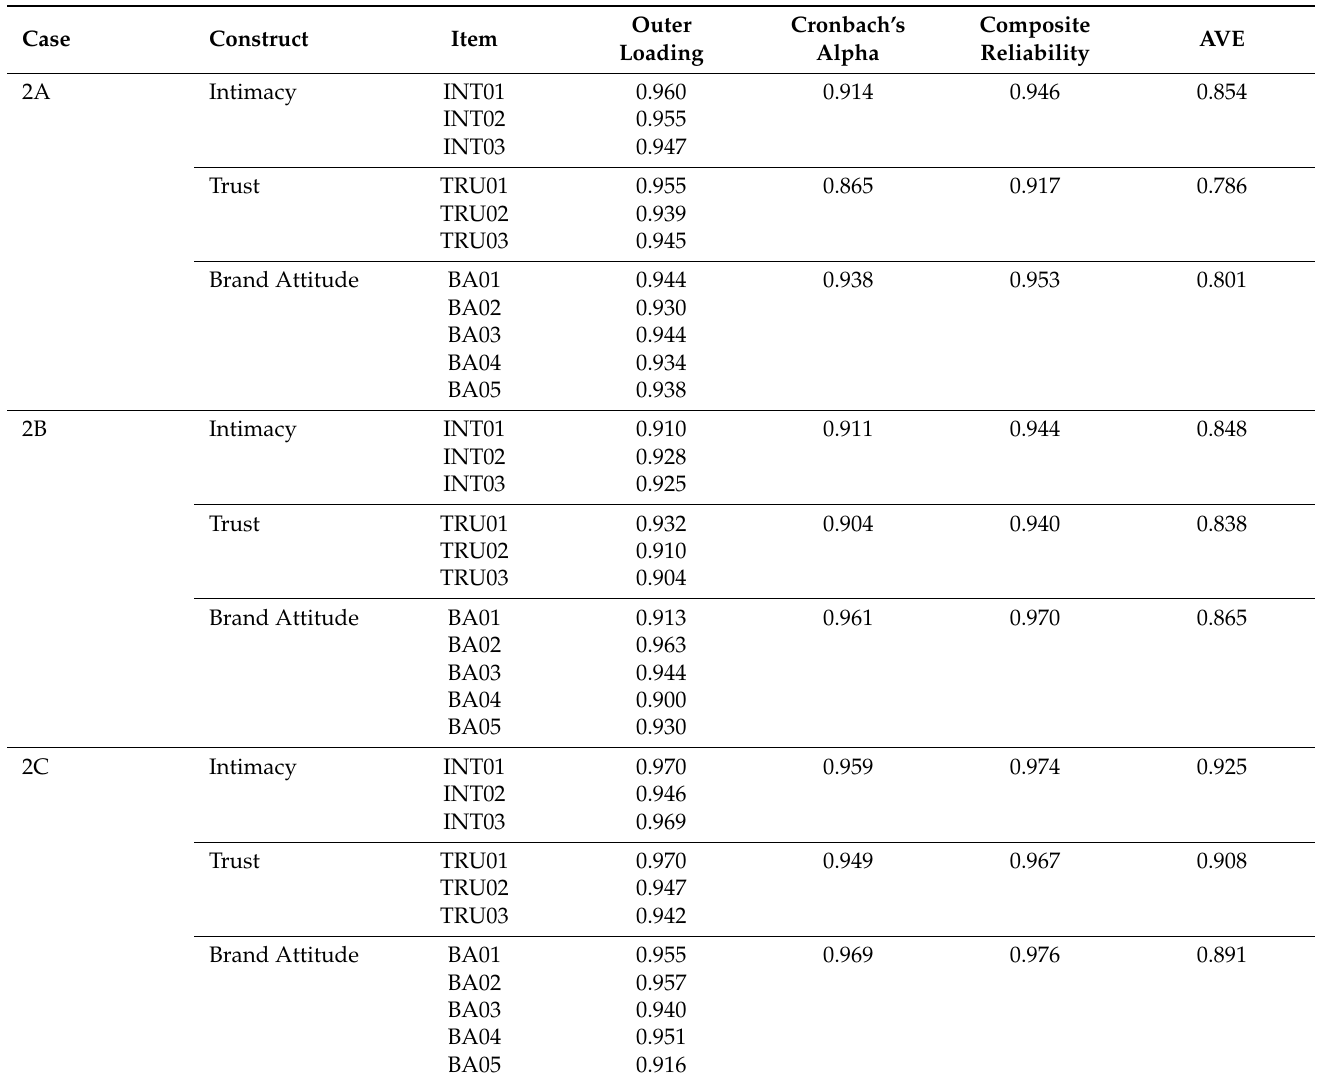
Table A3. Construct Validity and Reliability of each case in Public Transportation Service